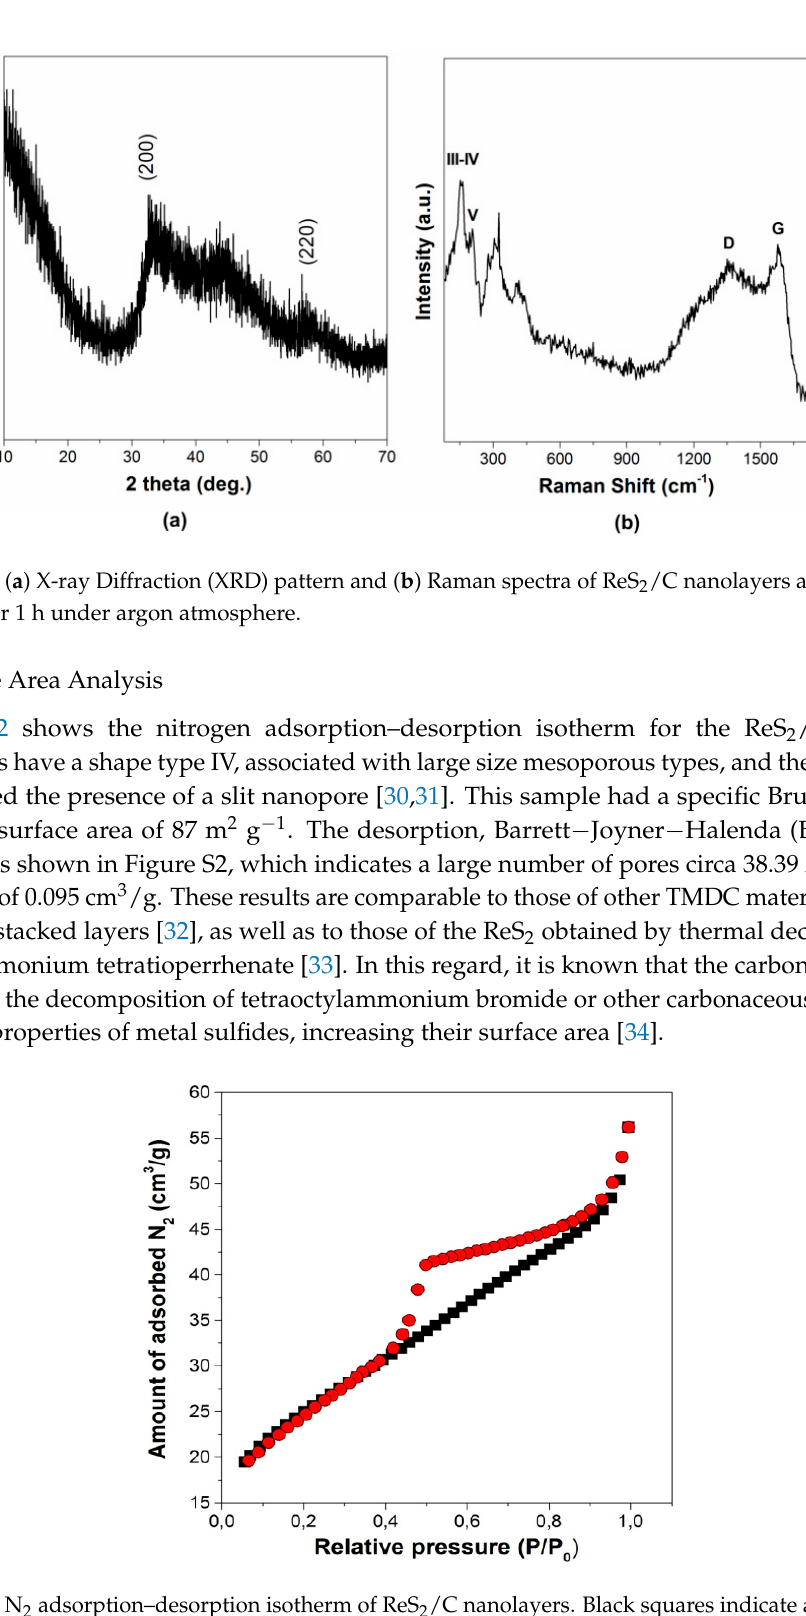
Figure 2. N 2 adsorption–desorption isotherm of ReS 2 /C nanolayers. Black squares indicate adsorption and the red circles desorption